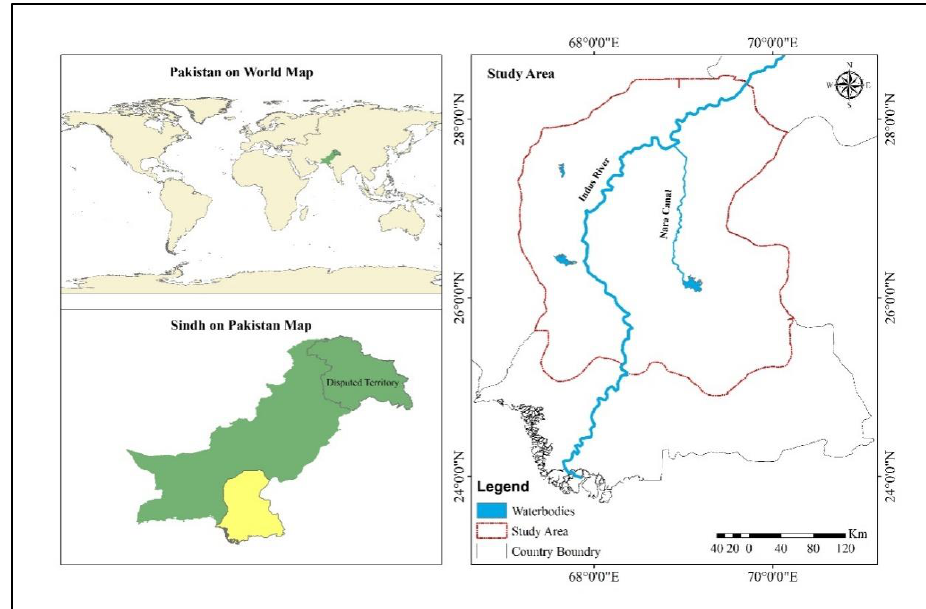
Figure 1. Location of study area.